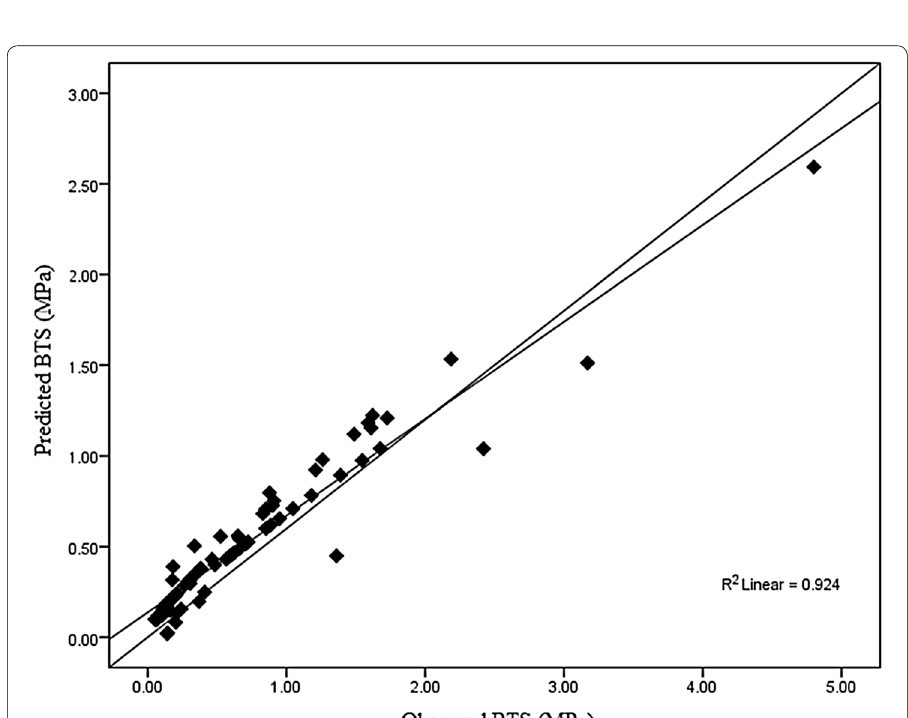
Fig. 4 Cross-correlation of predicted and observed values of BTS for regression model (Power